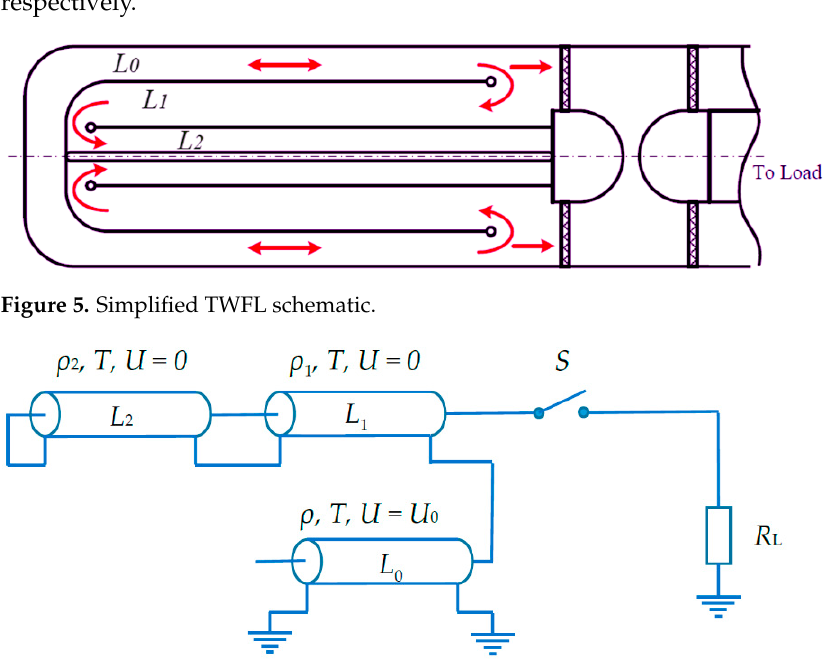
Figure 6. TWFL discharge circuit.